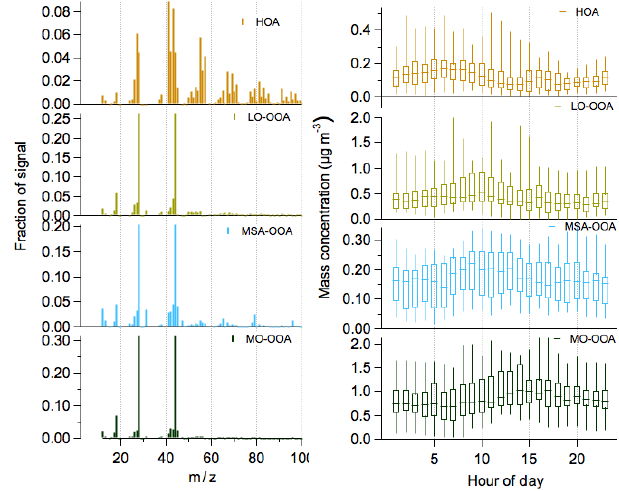
Figure 7. The mass spectra for the four PMF factors (HOA: hydrocarbon-like organic aerosol, LO-OOA: less oxidized OOA, MO-OOA: more oxidized OOA, MSA-OOA: methanesulfonic- acid-related OOA) retrieved from the PMF analysis of unit-mass resolution